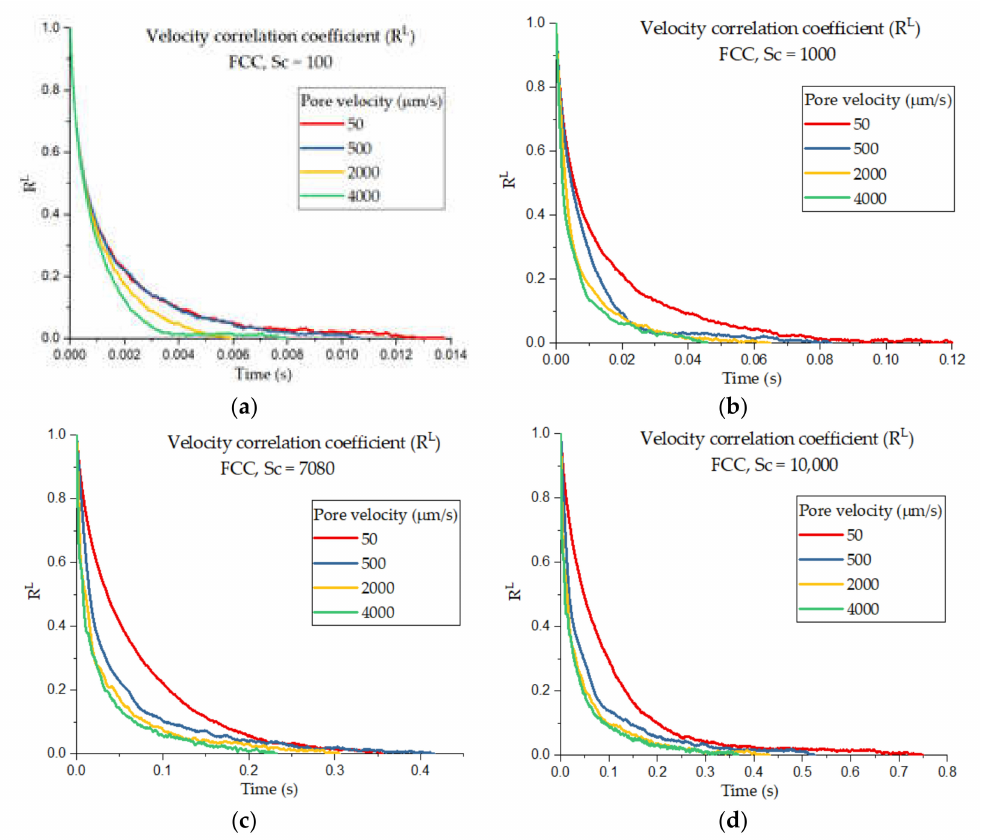
Figure 3. The velocity correlation coe ffi cient for the packed bed with an FCC geometry with time for ( a ) Schmidt number ( Sc ) = 100, ( b ) Sc = 1000, ( c ) Sc = 7080, and ( d ) Sc = 10,000. Each graph contains a velocity autocorrelation coe ffi cient for di ff erent average pore